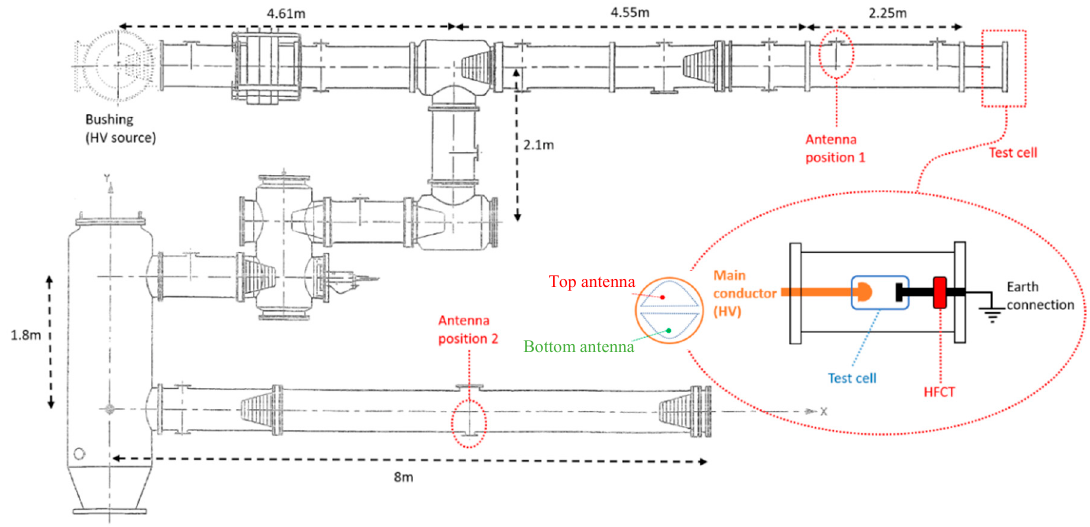
Figure 10. GIS layout with magnetic antenna locations.